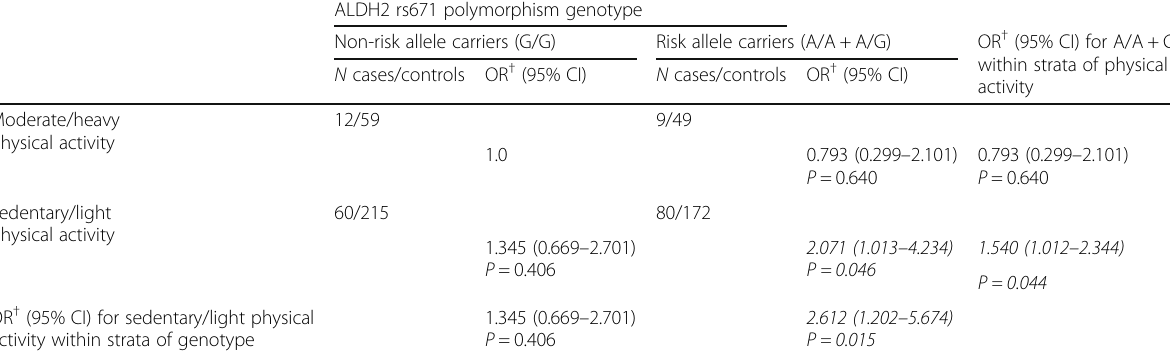
Table 5 Interaction between ALDH2 rs671 polymorphism and physical activity on CAD risk ALDH2 rs671 polymorphism genotype Non-risk allele carriers (G/G) Risk allele carriers (A/A + A/G) OR † (95% CI) for A/A + G/G N cases/controls OR † (95% CI) N cases/controls OR † (95% CI)